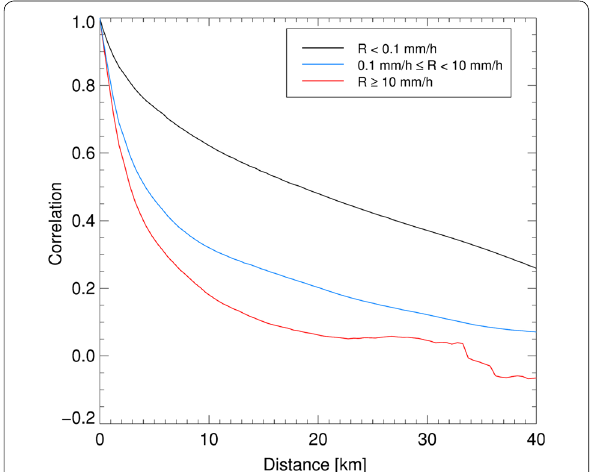
Fig. 7 Horizontal distance dependency of error correlation of PWV. Black, blue, and red colors indicate correlation coefficients at rain-free, weak rain, and heavy rainfall areas,